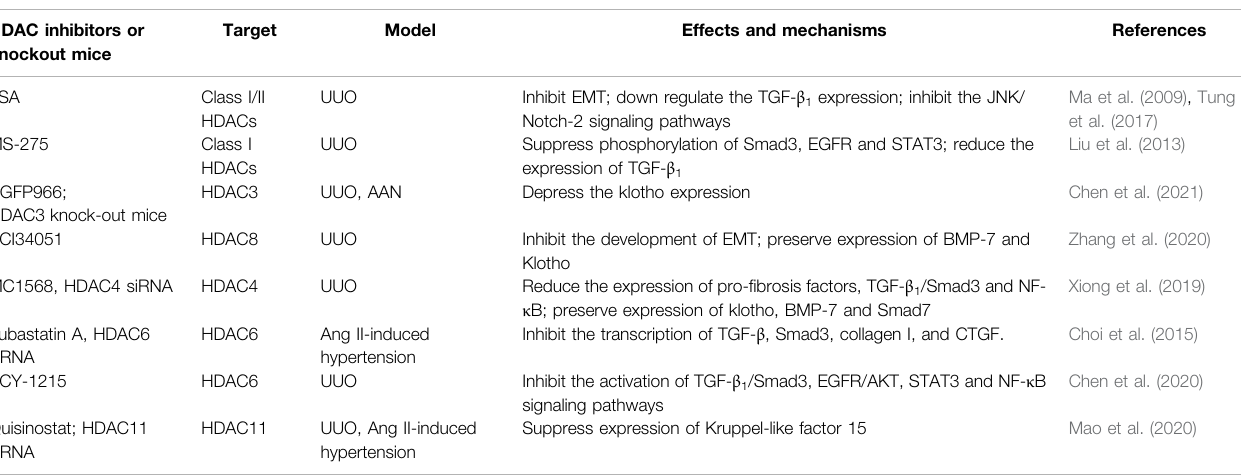
TABLE 2 | Effect of HDAC inhibitors or gene deletion on renal fi